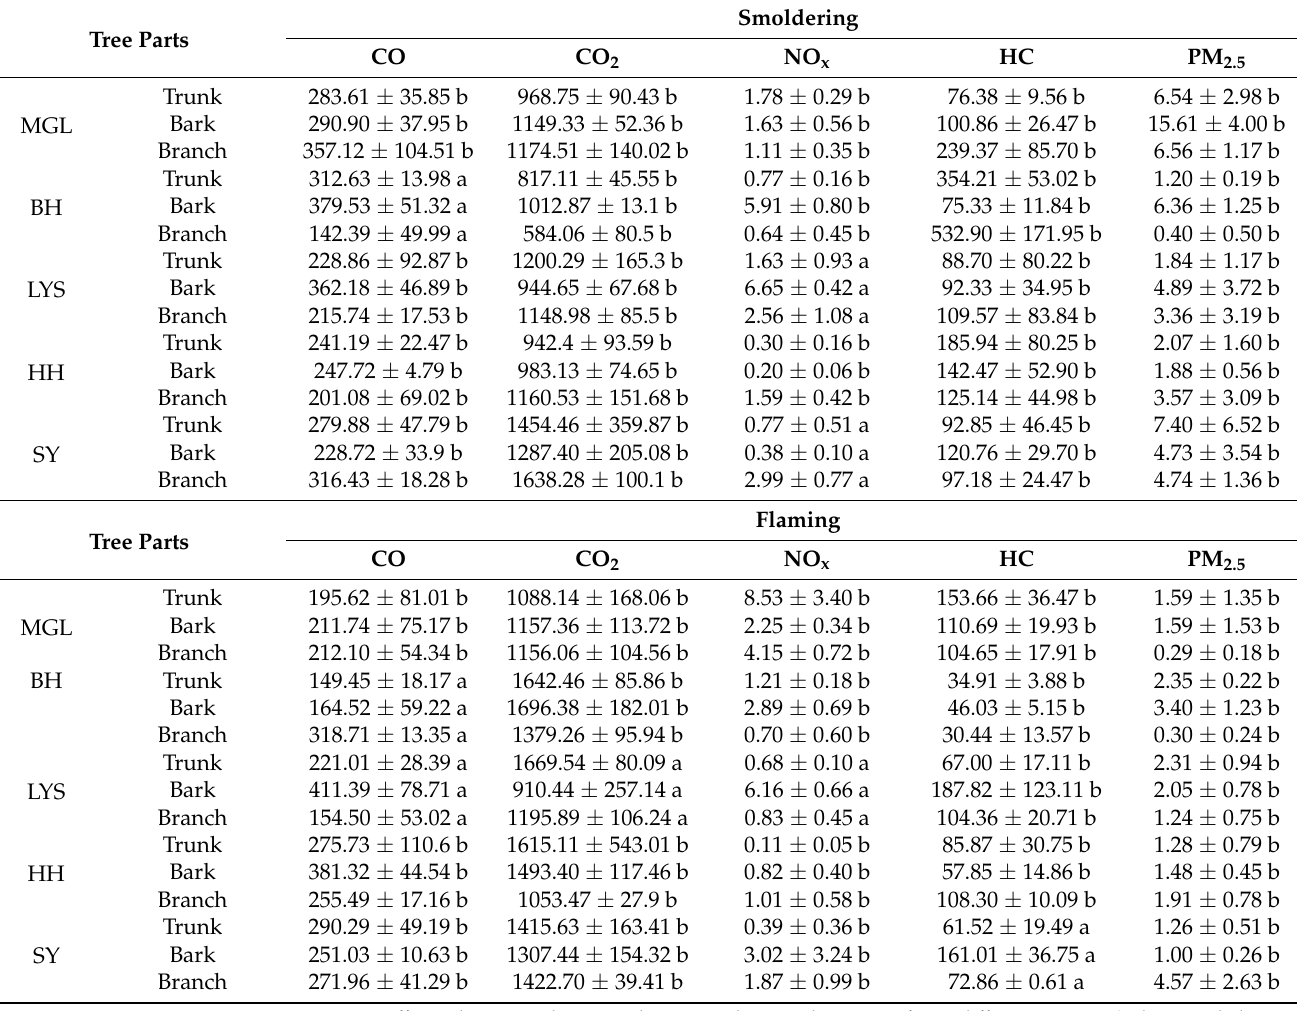
Table 1. Emissions of tree parts under different combustion states (mean ± standard deviation;